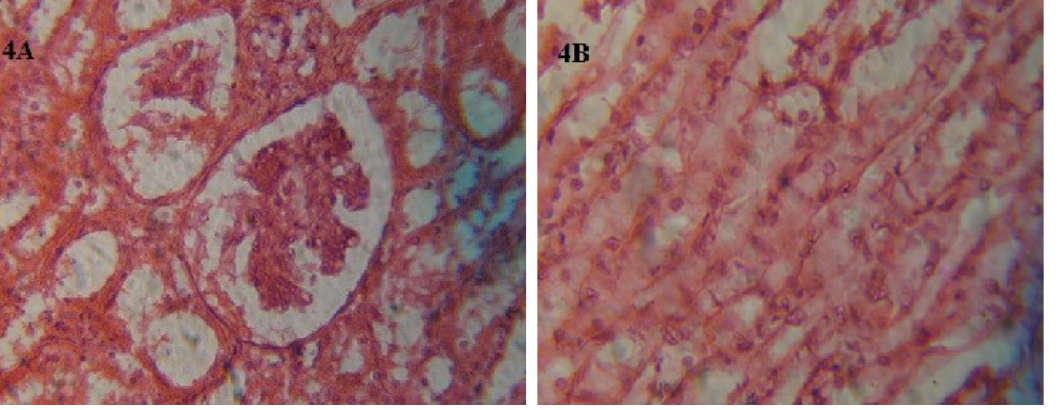
Figure 4: Microphotographs of Group GC-ze (Gentamicin and C. zeylanicum treated); (4A) renal cortex presenting normal struc- tures with some ruptured tubular cells and (4B) renal medulla presenting normal tubules with no proper evidence of